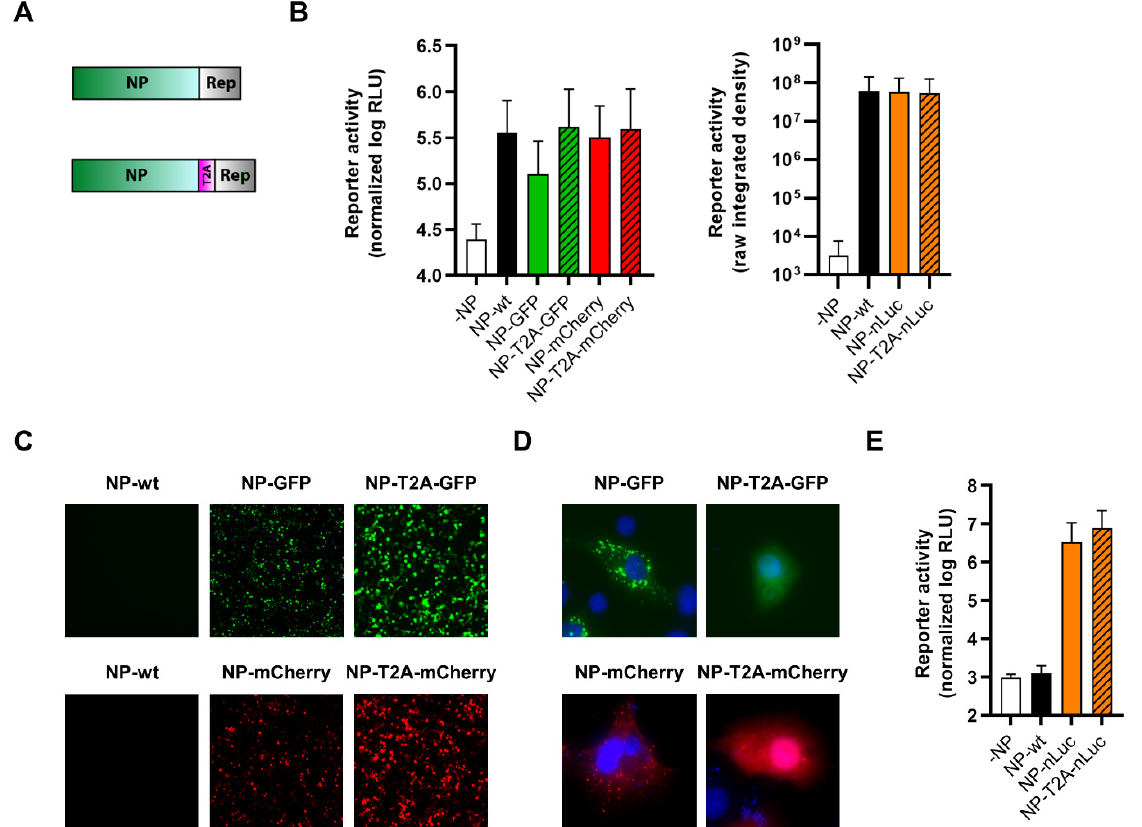
Figure 4. C-terminal fusion of TCRV NP to reporter proteins. ( A ) Schematic. Reporter proteins were C-terminally fused directly to TCRV NP (top) or separated by a T2A site (bottom). ( B ) Minigenome activity. BSR-T7/5 cells were transfected with plasmid components for either a nLuc-based minigenome assay (left), or a GFP-based minigenome assay (right). For nLuc-based minigenome assays (left), cells were lysed after 48 h and both nLuc and FLuc activities were measured. Results are shown as the mean ± SD of the log of nLuc activity normalized to FLuc activity from five independent experiments. For GFP-based minigenome assays (right), pictures of each well were taken and used to measure the raw integrated density in the GFP channel. Results are shown as the mean ± SD of two independent experiments. ( C ) Reporter activity (GFP/mCherry). Pictures of cells transfected as in ( B ) were taken 48 h post-transfection at 10× magnification. Results are shown as representative images from one experiment out of two independent experiments. ( D ) Reporter localization. Pictures of cells transfected as in ( B ) were taken 24 h post-transfection at 63× magnification after fixation and DAPI staining. Results are shown as representative images from one experiment out of two independent experiments. ( E ) Reporter activity (nLuc). Cells transfected as in ( B ) were lysed 48 h post-transfection, and nLuc activity in lysates was measured. Results are shown as mean ± SD of three independent experiments.